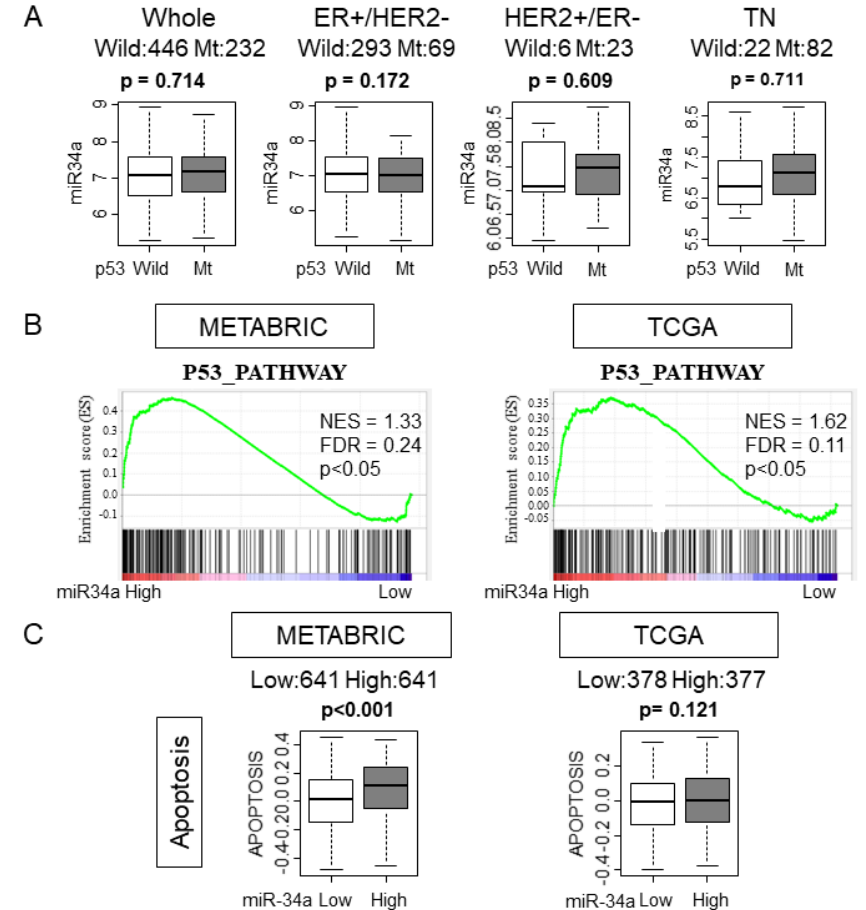
Figure 3. High MiR-34a expression tumors enriched the p53 pathway and apoptosis gene sets. ( A ) Expression levels of miR-34a of p53 wildtype or mutant in the whole cohort and in each subtype in the METABRIC cohort. ( B ) Gene set enrichment analysis (GSEA) of p53 pathway gene sets by miR-34a expression in METABRIC and The Cancer Genome Atlas (TCGA) cohort. ( C ) The association between miR-34a expression and GSVA scoring of Apoptosis in METABRIC and TCGA cohort. 2.5. High MiR-34a Expression Tumors Associated with Higher Epithelial–Mesenchymal Transition (EMT)